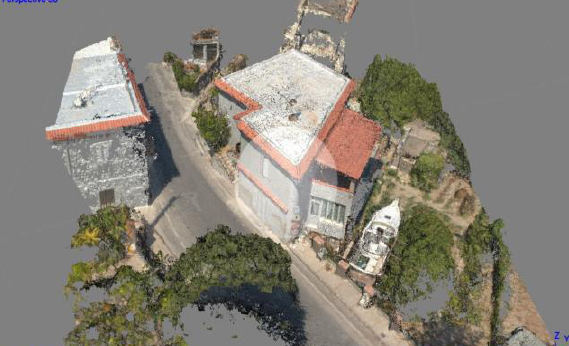
Figure 12. 3D Model of a building in Lacco Ameno